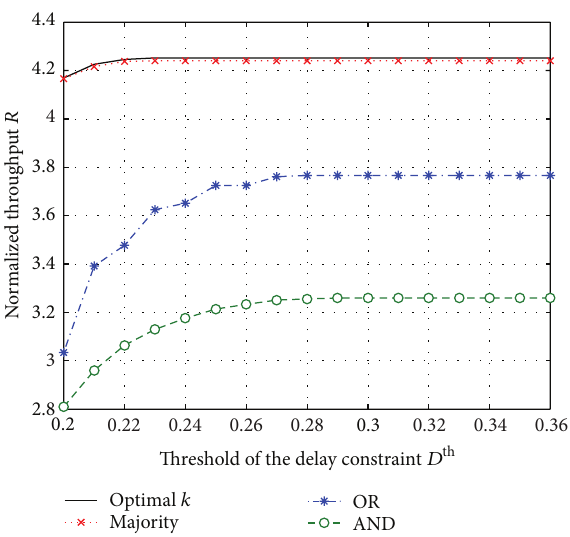
Figure 5: Normalized throughput R for various sensing